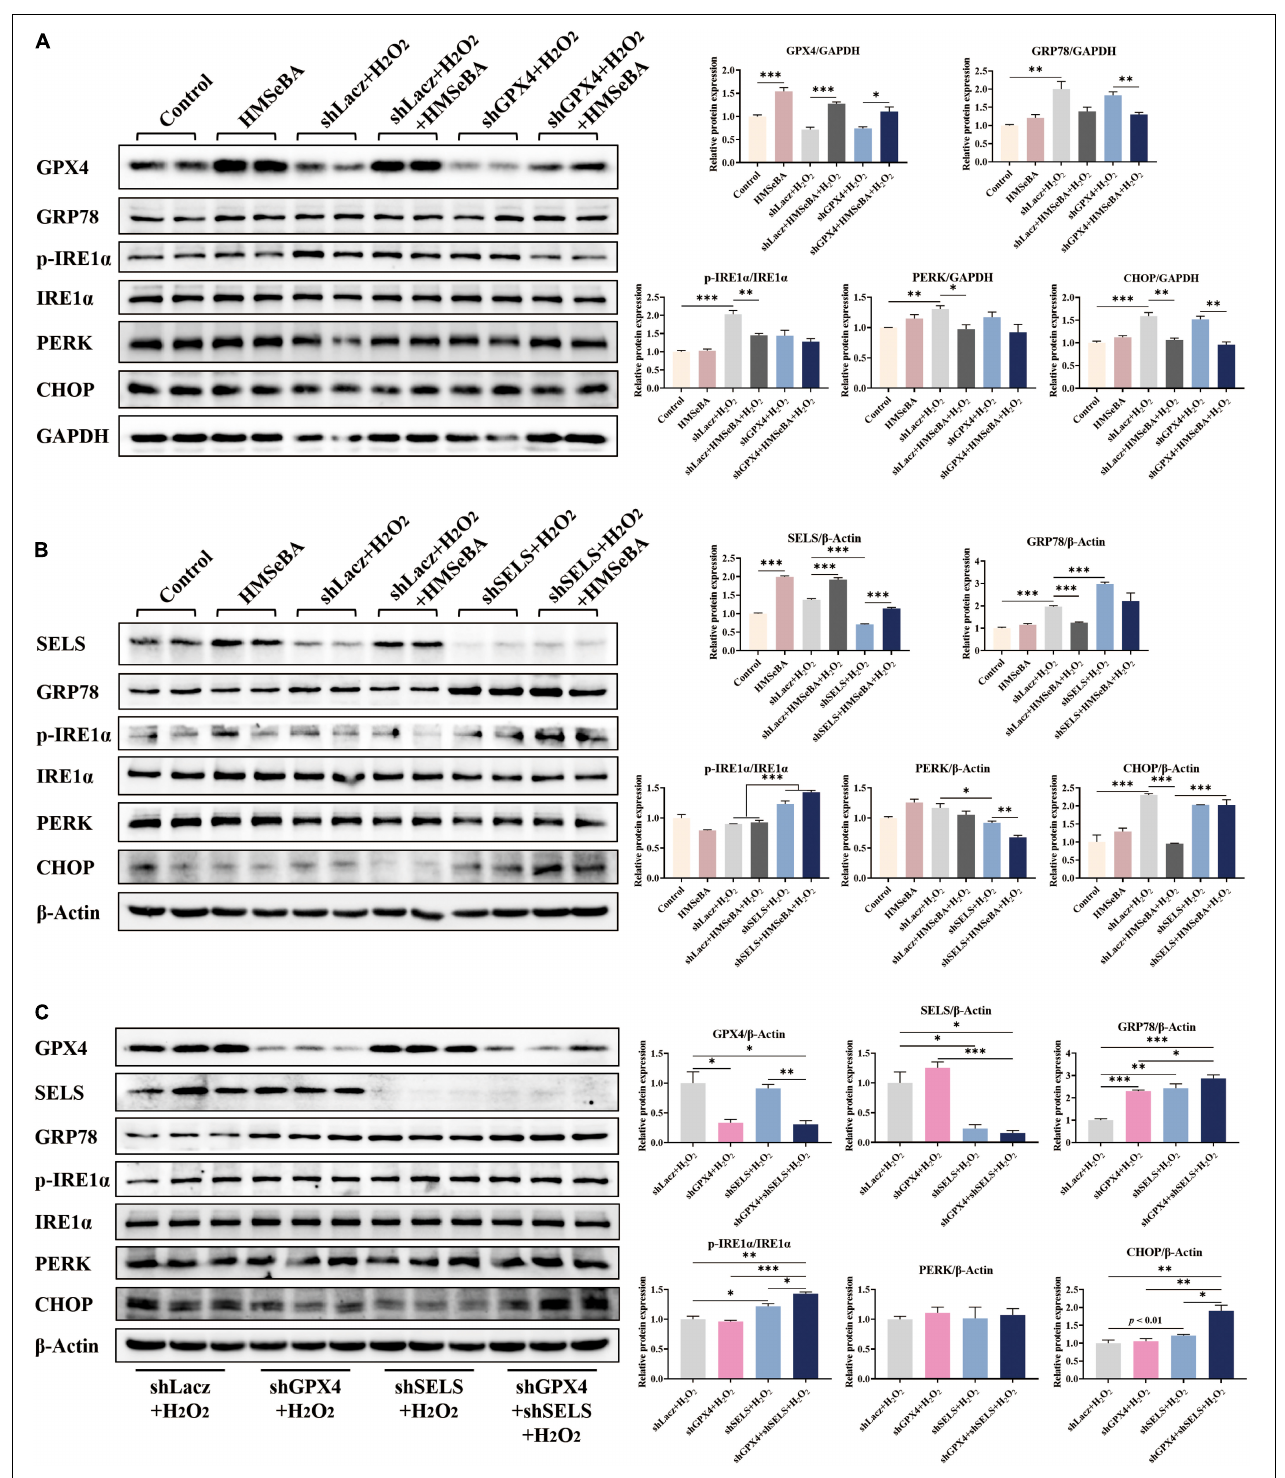
FIGURE 5 | Roles of GPX4 and SELENOS in regulating ER stress induced by H 2 O 2 in IPEC-J2 cells. (A) IPEC-J2 cells were infected with AdshGPX4, then were treated with H 2 O 2 plus HMSeBA. Protein levels of ER stress related markers were detected. (B) IPEC-J2 cells were infected with AdshSELS, then were treated with H 2 O 2 plus HMSeBA. Protein levels of ER stress related markers were detected. (C) IPEC-J2 cells were infected with AdshGPX4 or/and AdshSELS, then were treated with H 2 O 2 . Protein levels of ER stress related markers were detected n = 4 or 3 for western blot assay. Data are expressed as mean ± SE. ∗ P < 0.05, ∗∗ P < 0.01, ∗∗∗ P < 0.001.